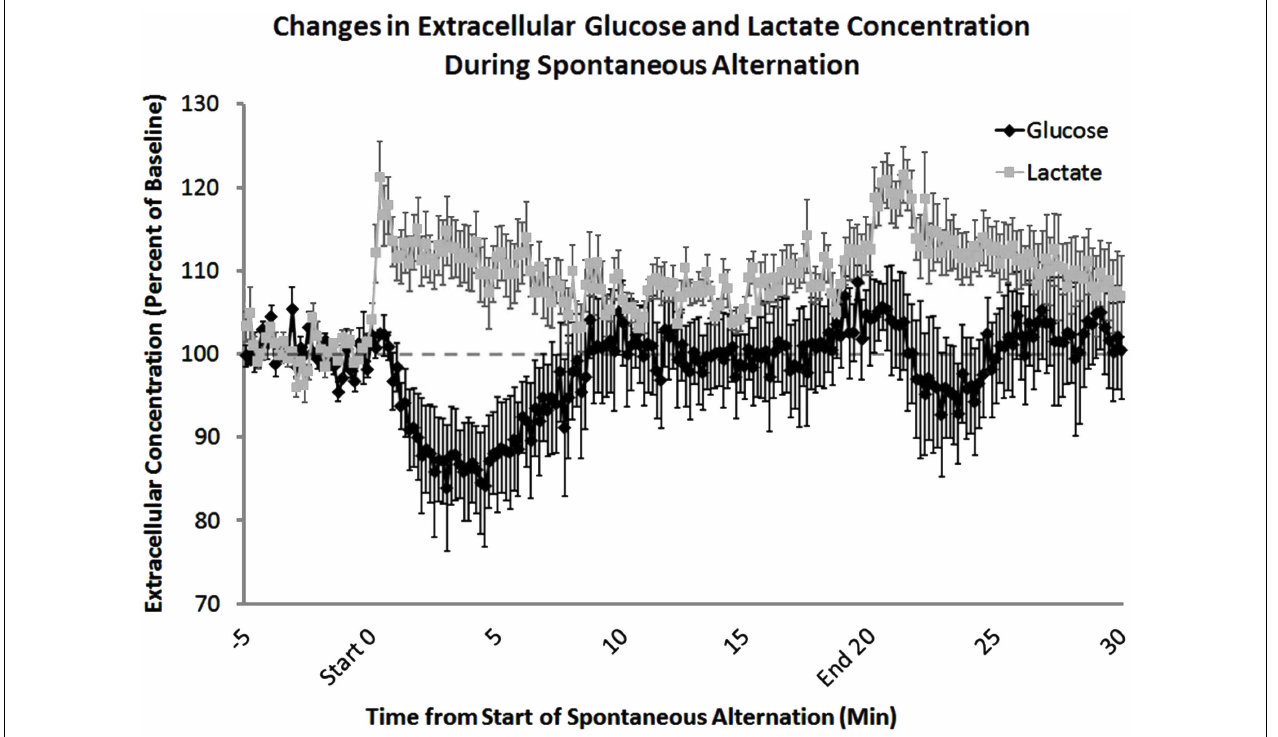
FIGURE 3 | Extracellular lactate and glucose levels in the hippocampus, measured before, during, and after behavioral testing. Using lactate- and glucose-specific biosensors, extracellular concentrations of both lactate and glucose were measured during spontaneous alternation testing. Lactate concentrations increased significantly at the beginning of behavioral